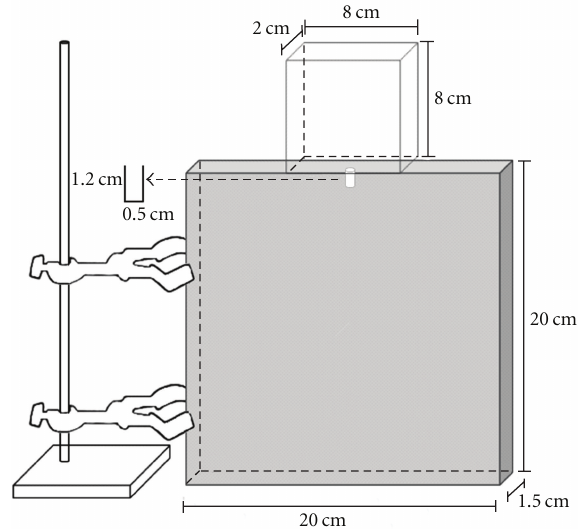
Figure 1: Experimental setup: the workers were allocated into a box with a pregiven tunnel to incite digging. The workers continued to dig for 48